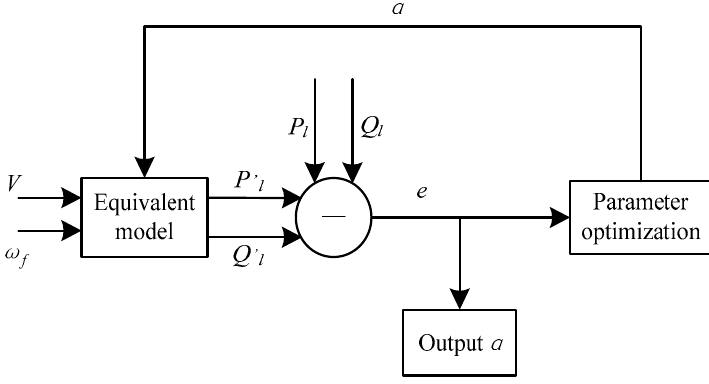
Figure 2. The equivalent schematic diagram of hydropower generator group.